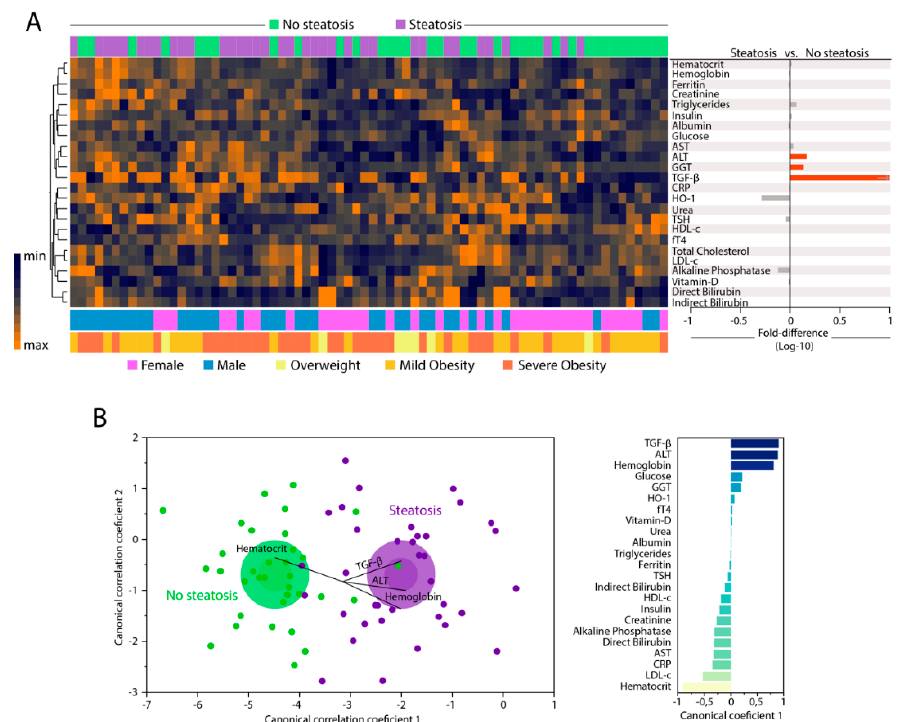
Figure 1. Changes in biochemical proteins of peripheral blood distinguish patients with and without hepatic steatosis. Plasma was assessed in samples from patients without hepatic steatosis (n = 36) and patients with hepatic steatosis (n = 36). Data were Log10 transformed and z-score normalized. ( A ) Left panel: In hierarchical cluster analysis (Ward’s method with 100X bootstrap) was employed to depict the overall expression of plasma proteins in study population. Right panel: Average fold-difference values in plasma proteins levels for patients with hepatic steatosis and without steatosis group. Differences which reached statistical significance with the Mann-Whitney U test adjusted for multiple comparisons using the Holm-Bonferroni’s method (Adjusted p < 0.05) are represented in colored bars. ( B ) Left panel: In an exploratory approach, a sparse canonical correlation analysis (sCCA) was employed to test whether experimental groups could be distinguished based on correlation profiles of the combined circulating markers. Vector analysis was used to plot the direction of influence of the most significant parameters in the canonical space. Right panel: Canonical coefficient scores were calculated to identify the biomarkers responsible for the difference between groups in the sCCA model. Abbreviations (alphabetic order): ALT: alanine aminotransferase; AST: aspartate